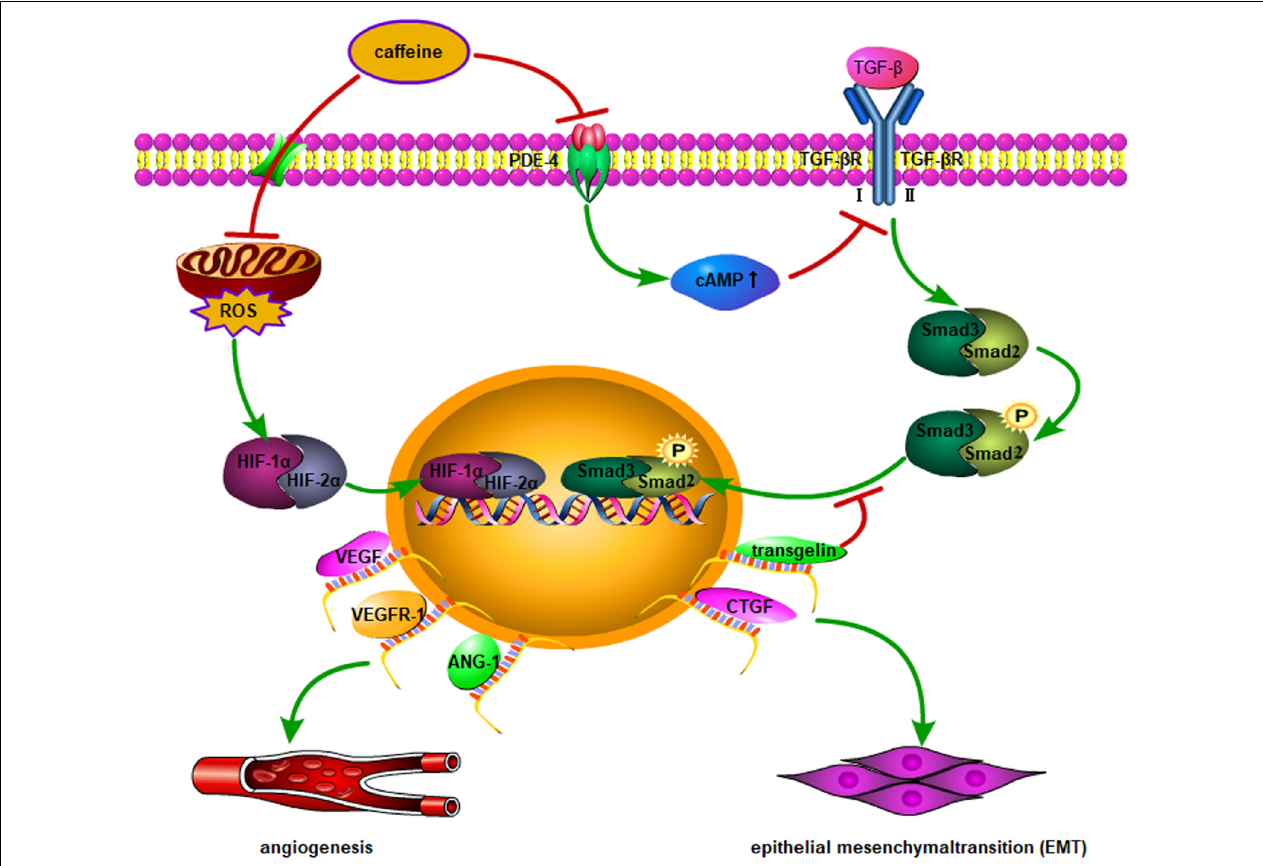
FIGURE 2 | Multiple genes are involved in angiogenesis and vascular remodeling though nuclear transcription activated by HIF-1 α /2 α . In addition to vascular remodeling, a higher expression level of angiopoietin-1, VEGF, and VEGFR1 may normalize lung histology in hyperoxia-induced lung injury after caffeine administration. Moreover, the effect of caffeine on Smad signaling appears to be mediated by inhibition of PDE-4, leading to an increase in intracellular cAMP, which is a possible regulator of TGF- β -mediated Smad phosphorylation and nuclear translocation. EMT activation is triggered by upregulation of CTGF and transgelin through the above-mentioned pathways. ROS, reactive oxygen species; TGF- β , transforming growth factor- β ; TGF- β R, TGF- β receptor; PDE-4, phosphodiesterase-4; CTGF, connective tissue growth factor; cAMP, cyclic adenosine monophosphate; VEGF, vascular endothelial growth factor; VEGFR-1, VEGF receptor-1; EMT, epithelial mesenchymal transition; ANG-1, angiopoietin-1; HIF-1 α , hypoxia-inducible factor-1 α ; HIF-2 α , hypoxia-inducible factor-2 α